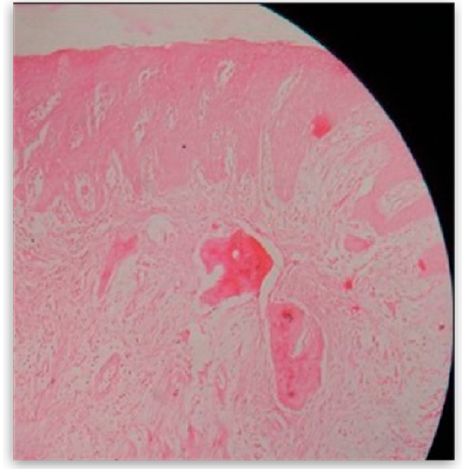
Figure 8. Histological finding of the preparation at magnification 4×.